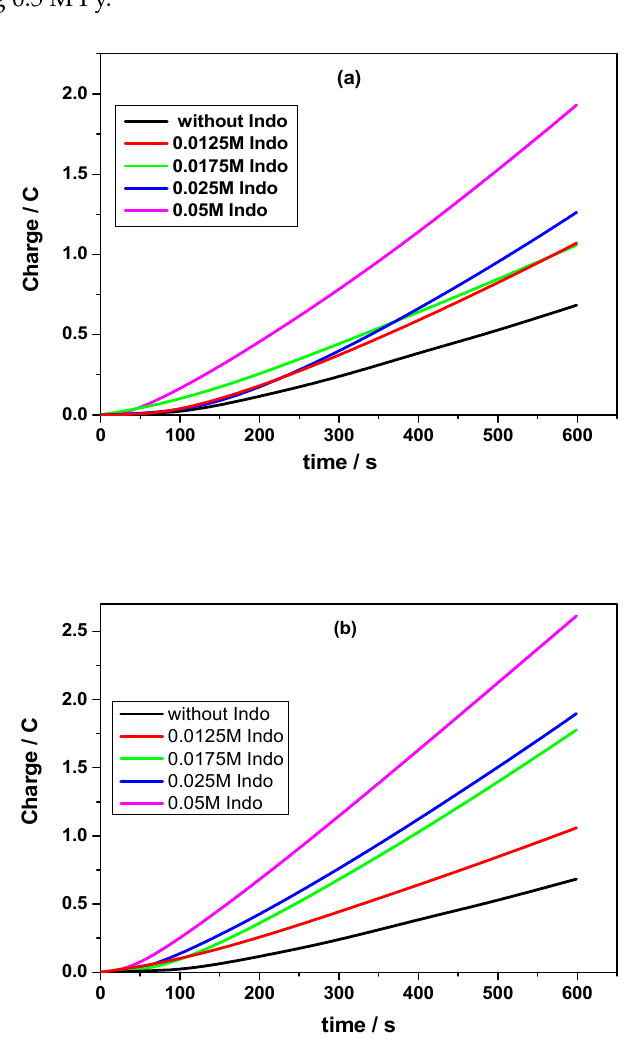
Figure 5. Charge–time plots during electrosynthesis of PPy and PPy-Indo at a constant potential of 1.1 V / Ag for 600 s on IB ( a ) and ND ( b ) NiCr alloys from ILM-ACN electrolyte containing 0.5 M Py in the absence and in the presence of various Indo concentrations.